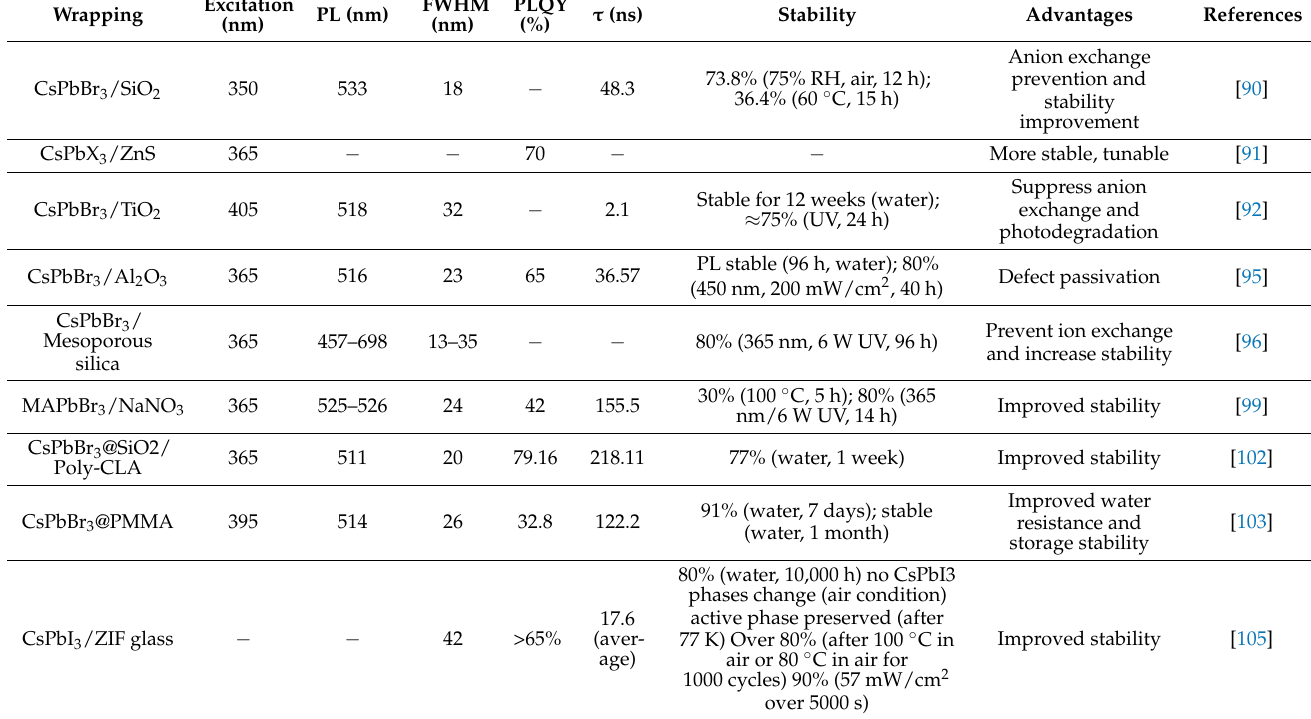
Table 3. Luminescence properties of PQDs realized with different packaging materials and methods.